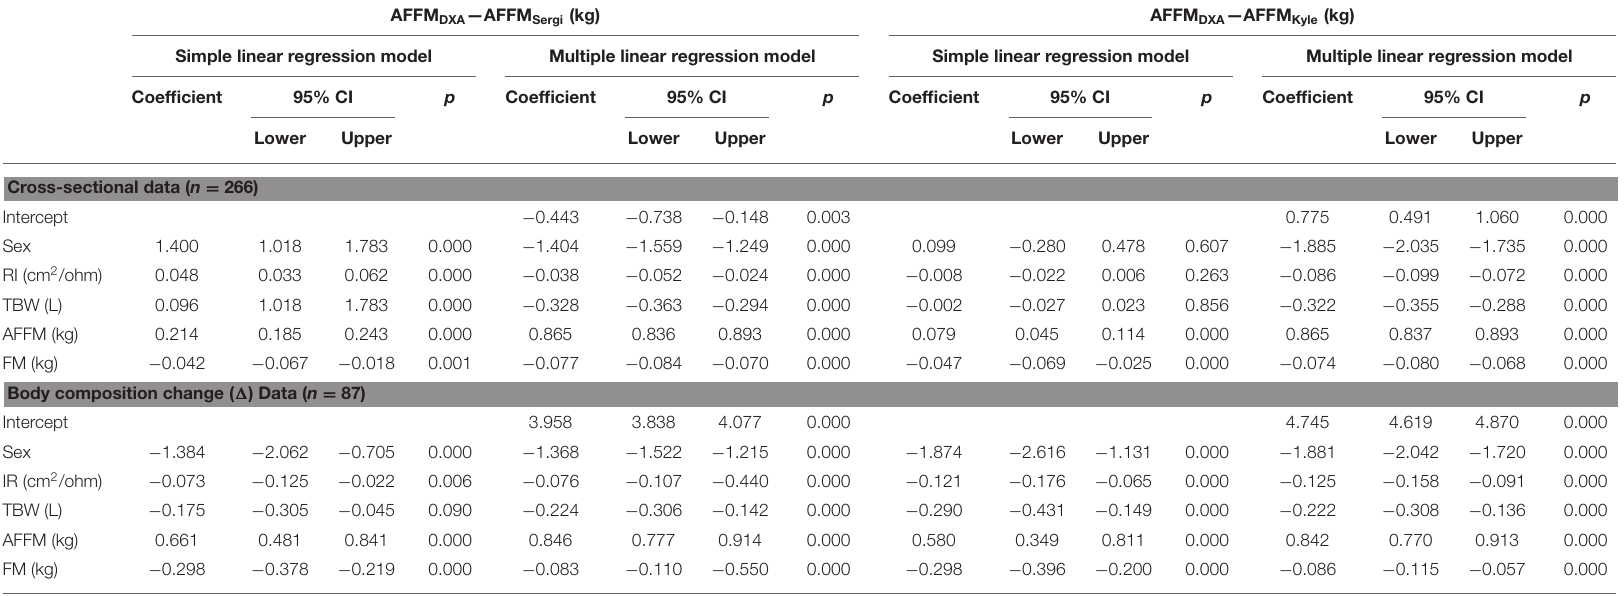
TABLE 5 | Simple and multiple linear regression models for factors associated with bias in agreement between DXA and prediction equations in total